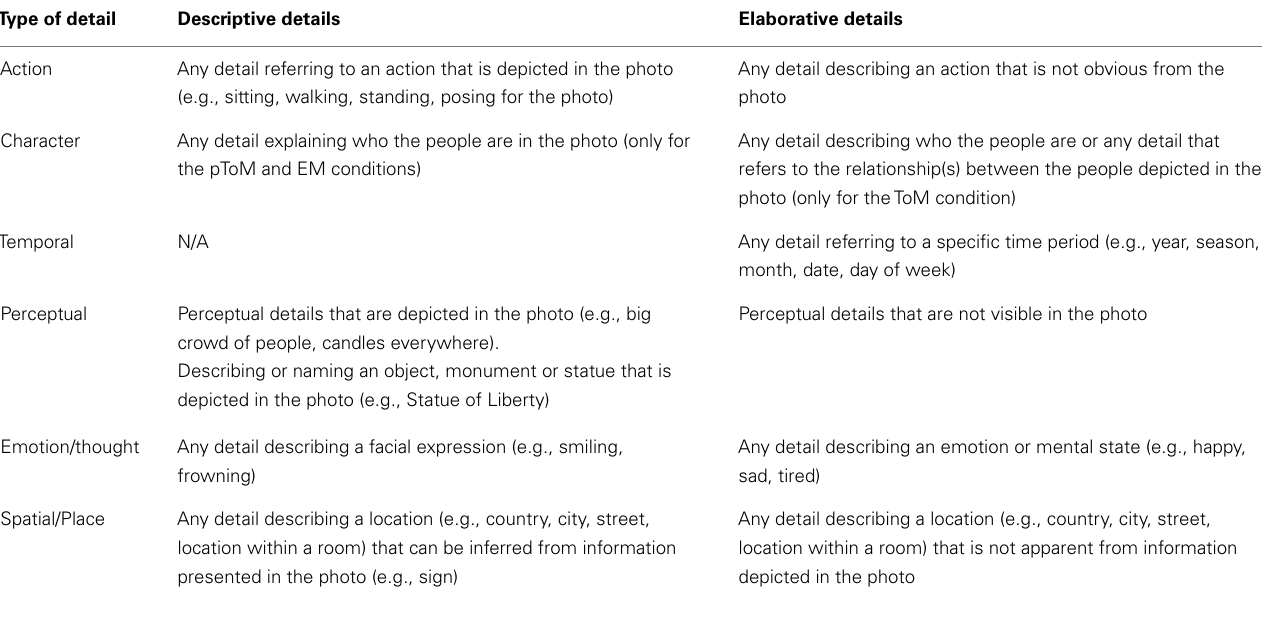
Table 1 | Classification of descriptive versus elaborative